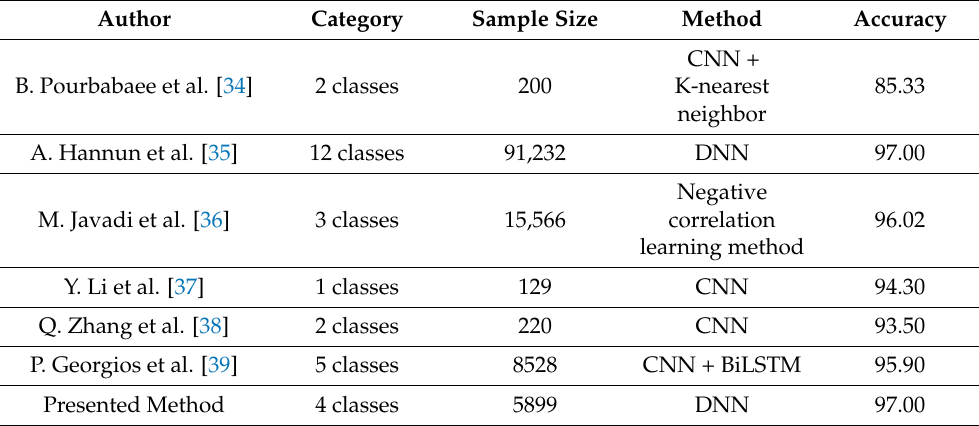
Table 5. Comparison of proposed scheme with existing